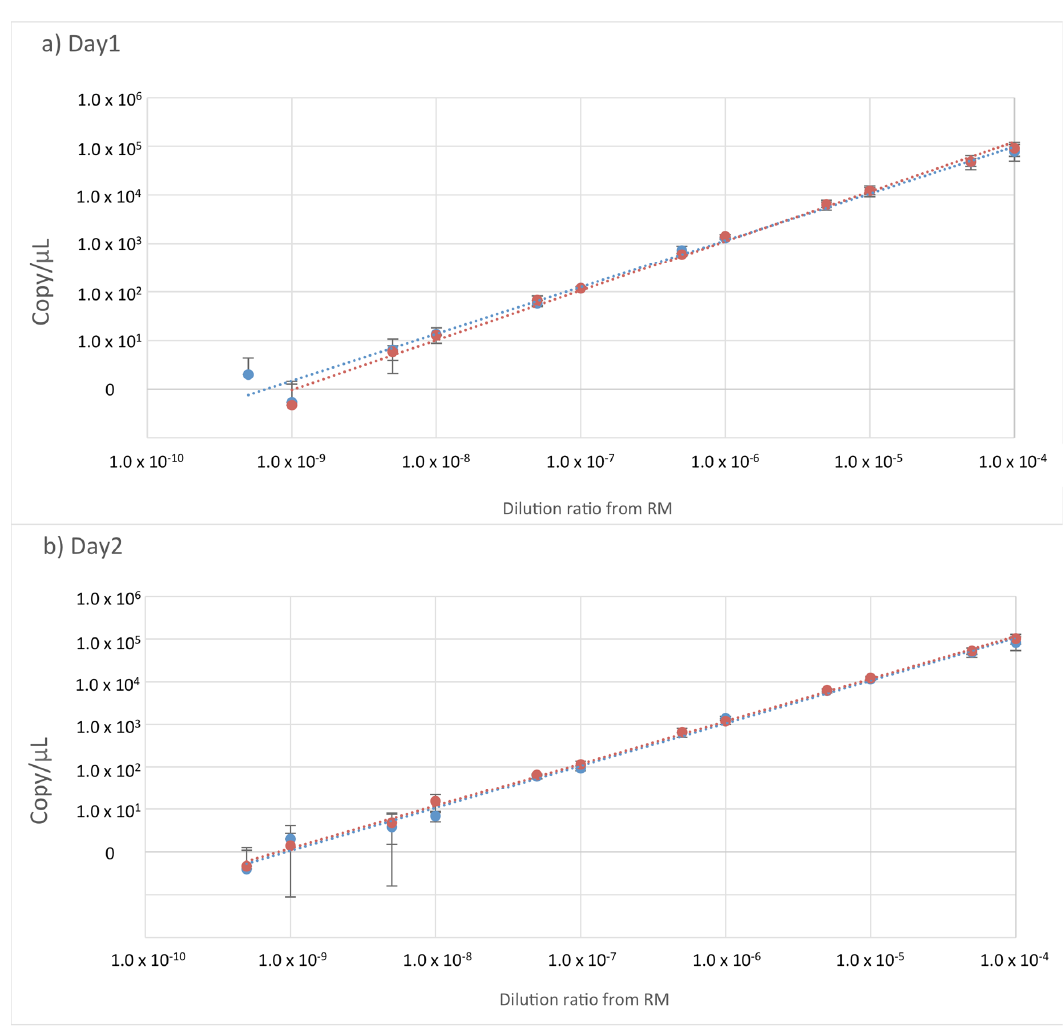
Figure 1. Droplet digital (dd)PCR quantitation and limit of detection (LOD). ( a , b ) Log–log graph with a regression line between serial dilutions and copy number concentrations at days 1 and 2, respectively. Blue circles denote use of SET1, and red circles denote SET2. The horizontal axis shows the dilution ratios from the reference material (RM) of serial dilution (SD)4.0 through SD9.5. The vertical axis shows copy number concentration in each SD. The slope indicates amplification efficiency.